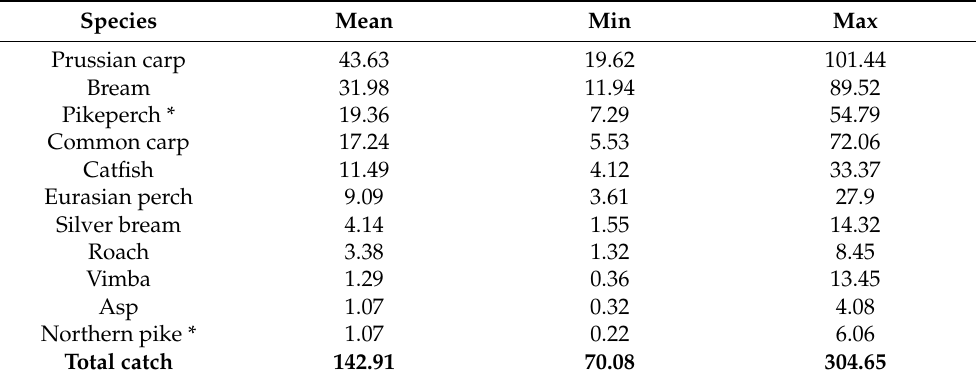
Table 1. Estimated annual recreational catches (average over 2016–2021), in tons per year, for the main fish species in Kaunas Reservoir, assuming that fishing effort remained approximately